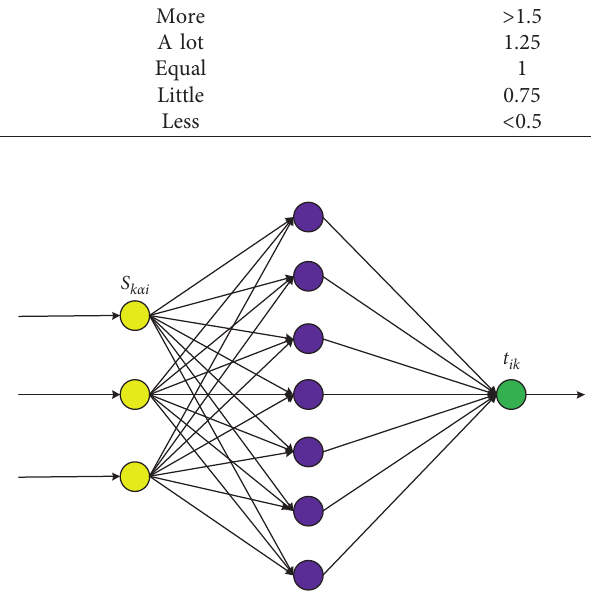
Figure 3: The topology diagram of BP neural